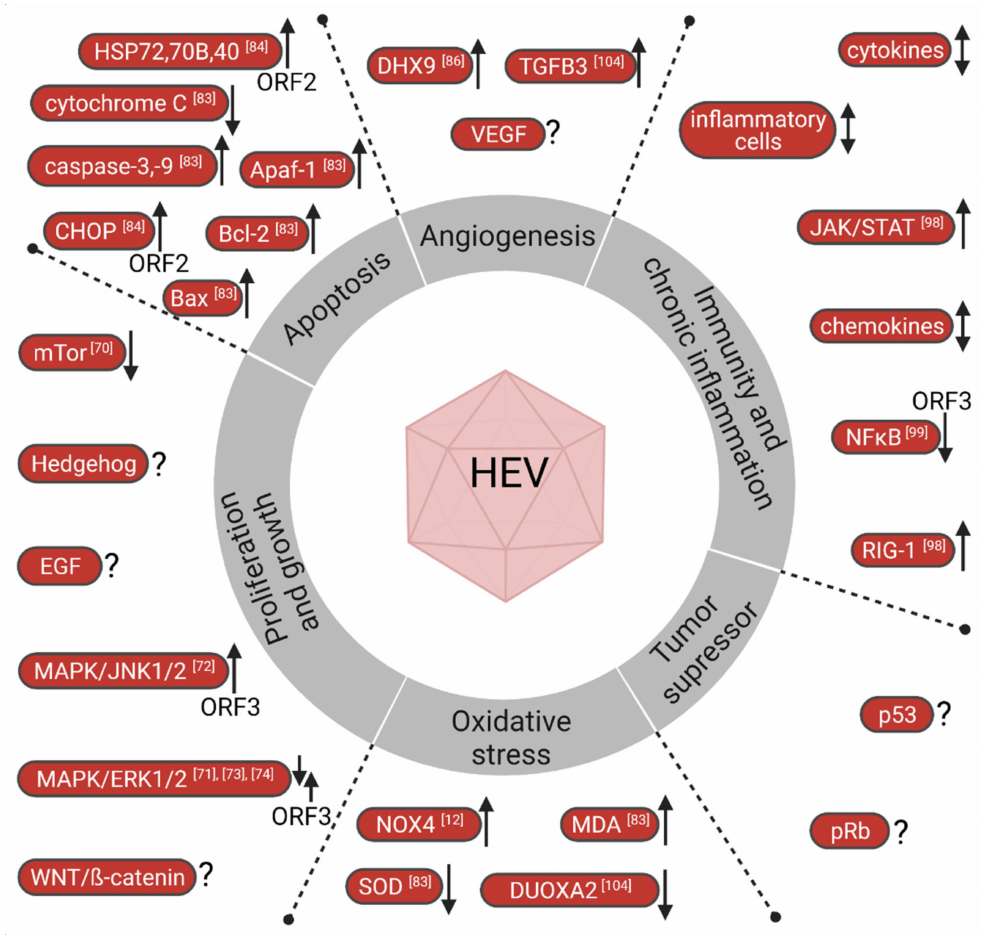
Figure 2. HEV involvement in known cancer pathways and outlook on putative research targets. Upward facing arrows indicate upregulation/activation while downward facing arrows indicate downregulation/inhibition of respective factors. Question marks indicate knowledge gaps of recog- nized cancer-induced factors, paired arrows facing up and down indicate contradicting data and up-down arrows indicate groups of signal proteins that could be activated and inhibited. Illustration was created with